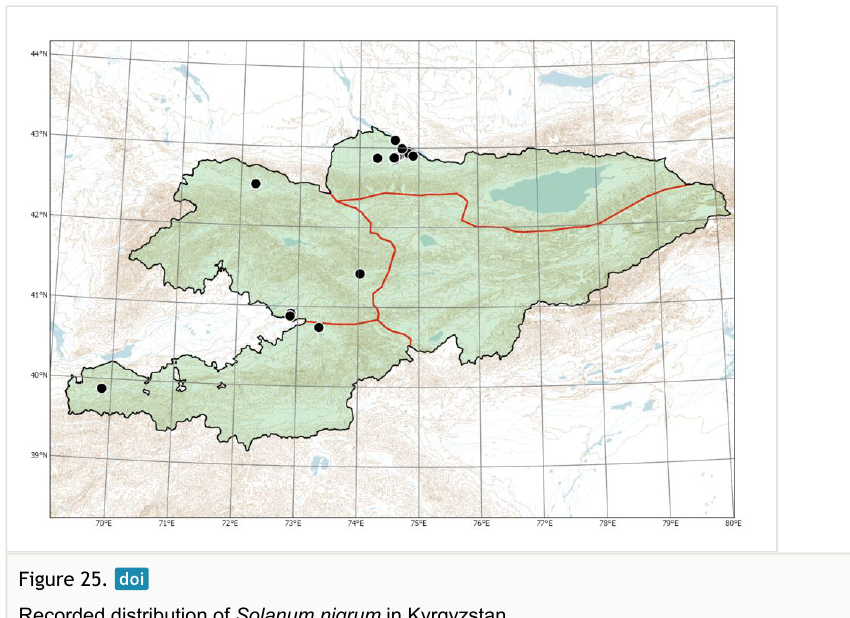
Recorded distribution of Solanum nigrum in